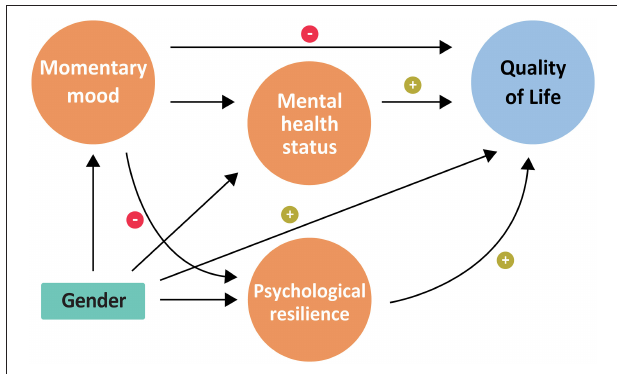
FIGURE 1 | A theoretical framework to account for QoL from gender, psychological resilience, mental health and momentary